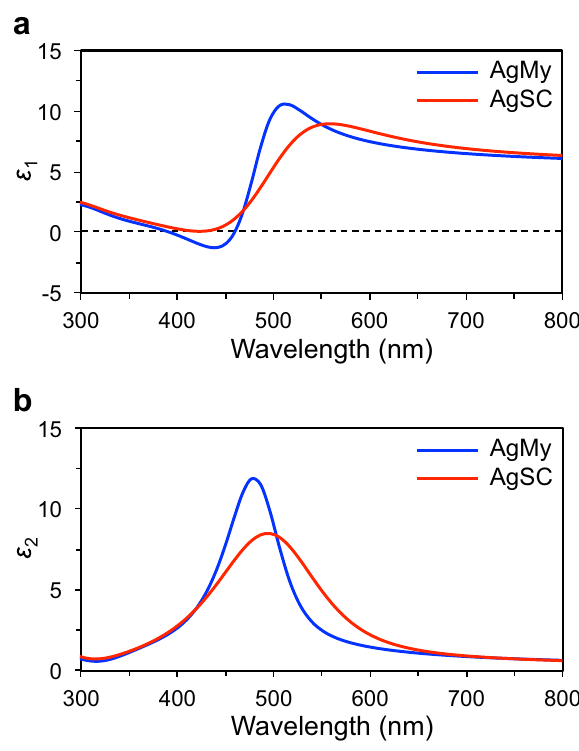
Fig. 4 Complex dielectric functions of AgMy and AgSC fi lms measured by ellipsometry. a Real parts ε 1 of the complex dielectric function for AgMy (blue) and AgSC (red). Compared with that of AgSC, the ε 1 value of AgMy indicates a longer mean free path and smaller damping factor of the electrons that contribute to the LSPR; moreover, the electrons oscillating with the frequency corresponding to the negative value of ε 1 in AgMy can behave as free electrons without the CID effect. b Imaginary parts ε 2 of the complex dielectric function for AgMy (blue) and AgSC (red). The higher peak intensity of ε 2 for AgMy fi lms indicates a higher conductivity of electrons oscillating as the LSPR in AgMy compared with that in